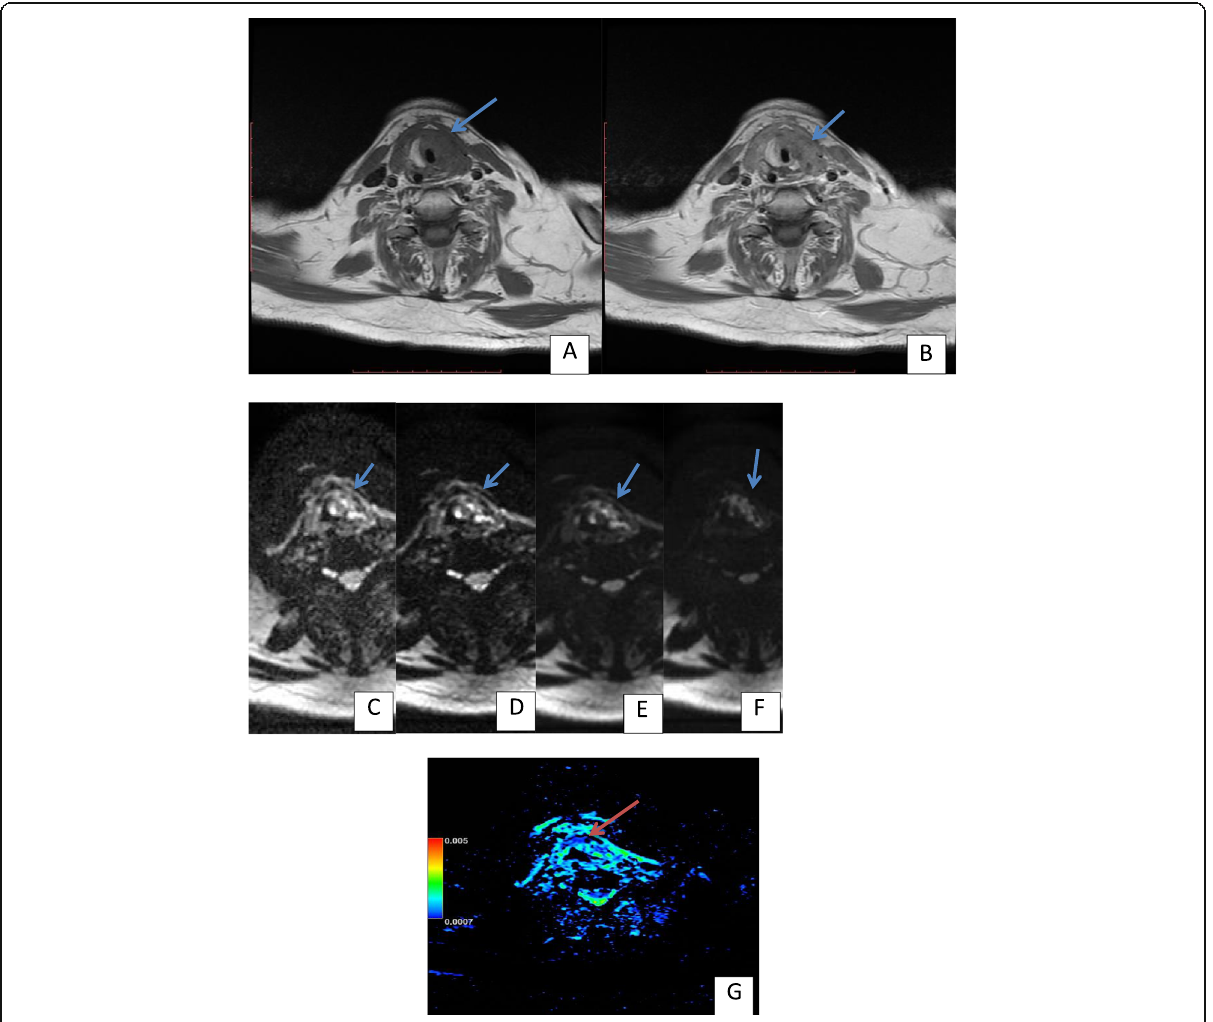
Fig. 3 Sixty-four-year-old male patient with invasive laryngeal squamous cell carcinoma grade 2. a Axial T1. b Axial T1 + C. c – f Axial diffusion- weighted imaging with b values: 50, 400, 800, and 1000 respectively. g ADC map. The mass showed isointense signal in T1 with small areas of necrosis, homogenous enhancement of solid tissue after IV contrast. It elicited high signal in DWI, in both low and high b values with